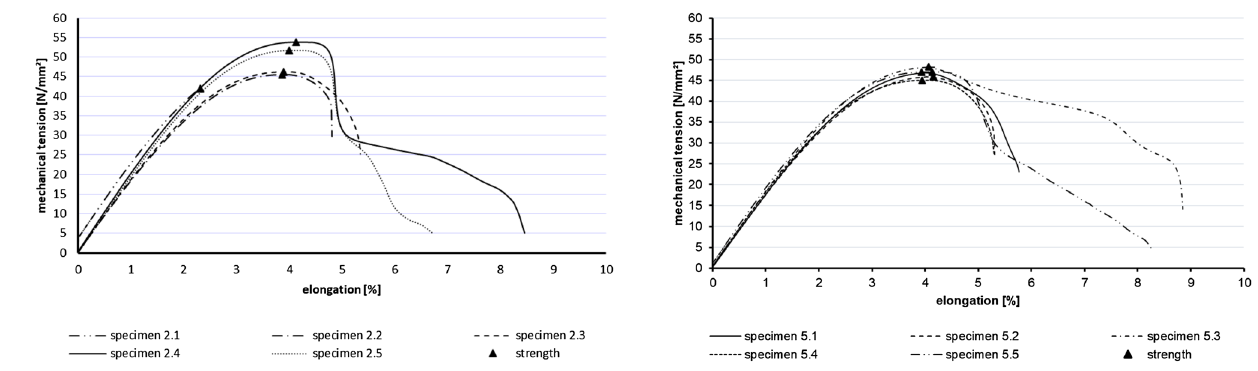
Fig. 18 Stress–strain diagram sample 5 (Verbatim